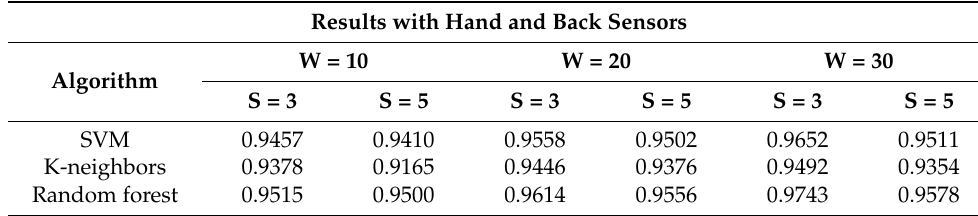
Table 6. Maximum values obtained for the right classifier in three-sensor mode.